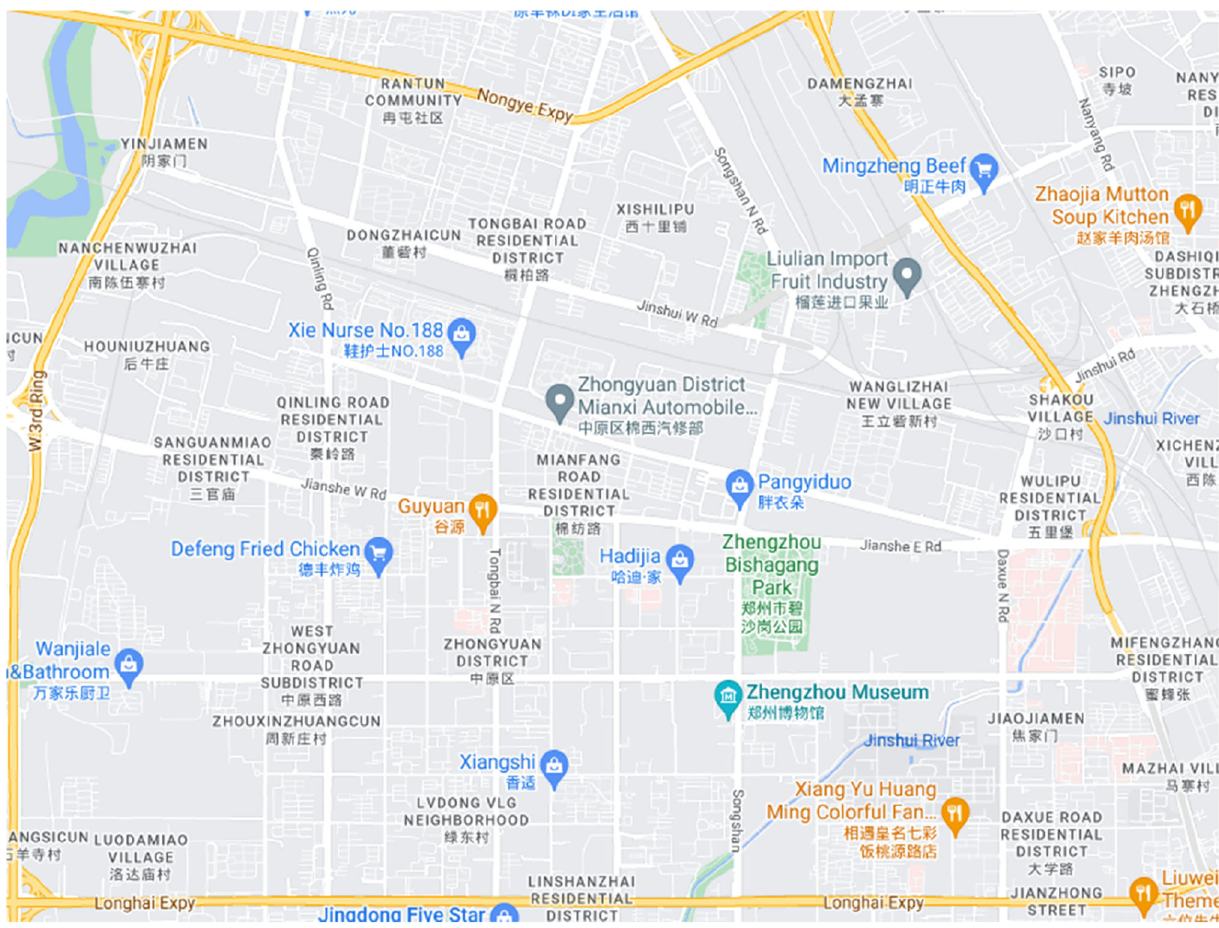
Fig. 6 Road network diagram of the patrol district